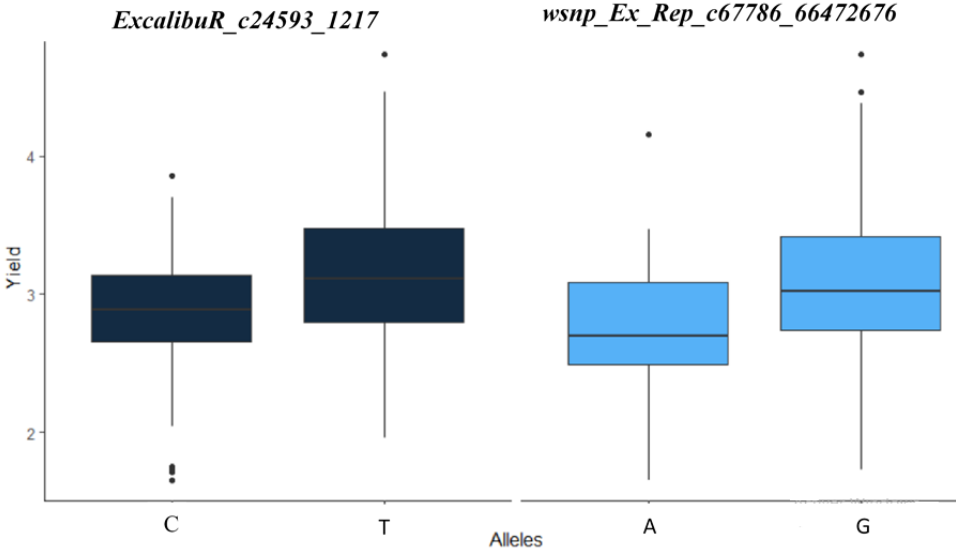
Figure 2. Average grain yield (t ha − 1 ) depending on the base pair of single nucleotide polymorphism of the two markers “ExcalibuR_c24593_1217” (7A, 42 cM) and “ wsnp_Ex_Rep_c67786_66472676 ” (3A, 110 cM) at the Sidi El Aidi